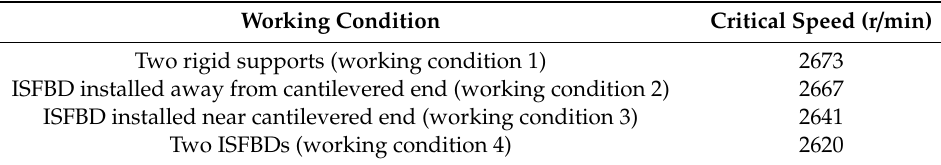
Figure 13. Influence of ISFBD on critical speed. Table 2. Critical speed under different working conditions.